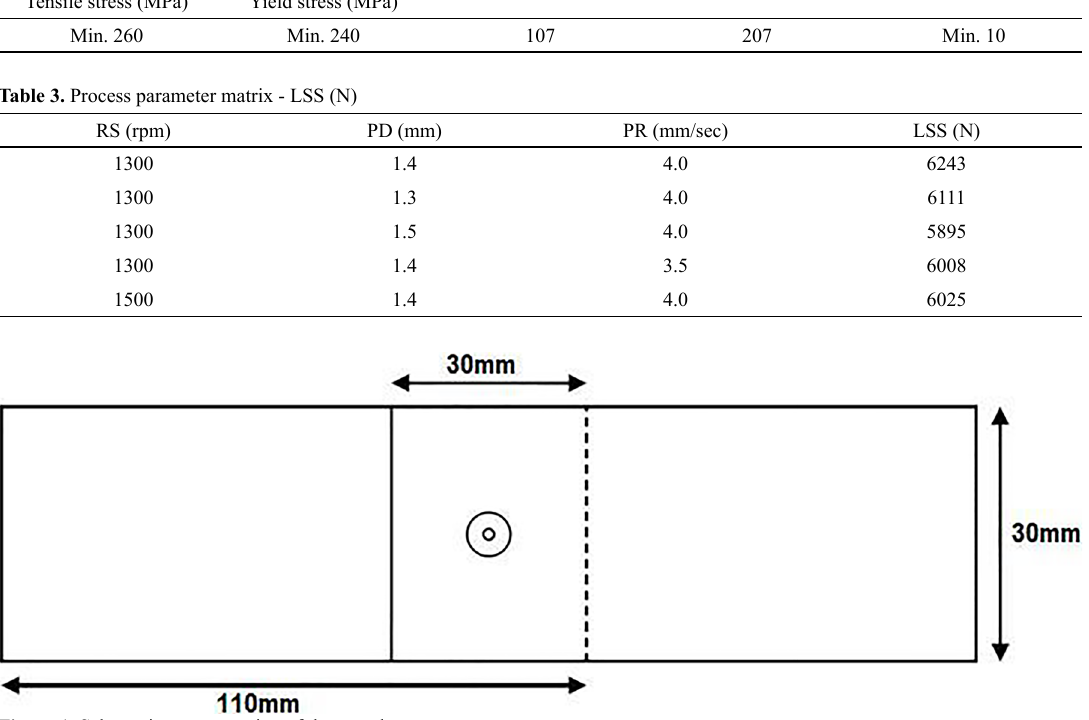
Figure 1. Schematic representation of the